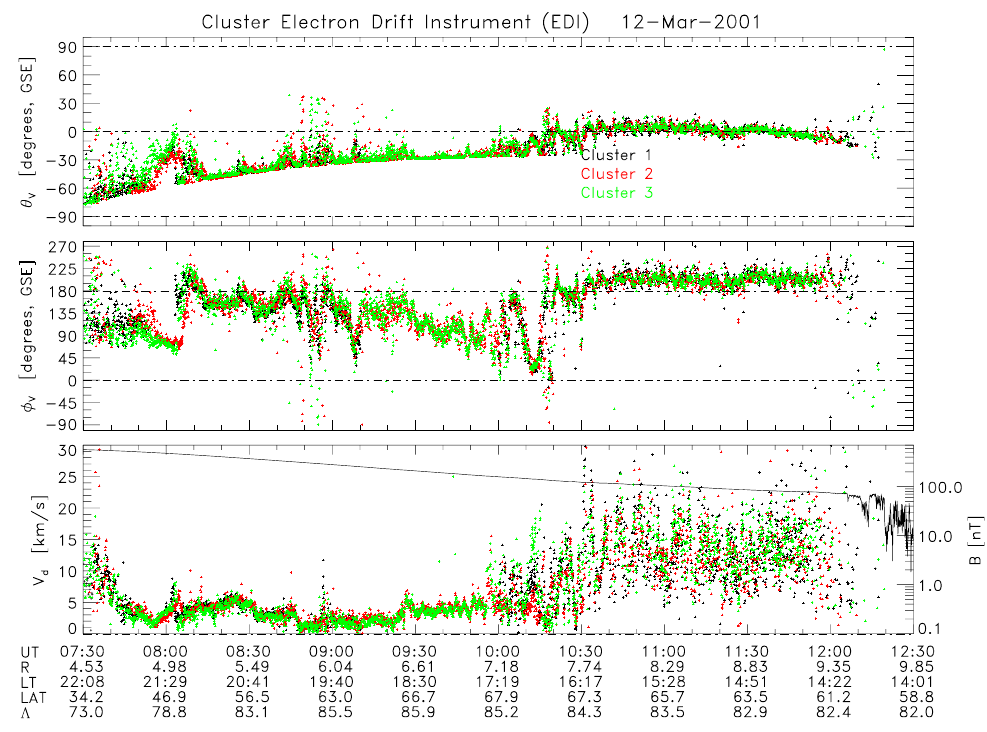
Fig. 7. The same data as in Fig. 6, except that the drift directions are now in GSE and the spacecraft motion has been corrected